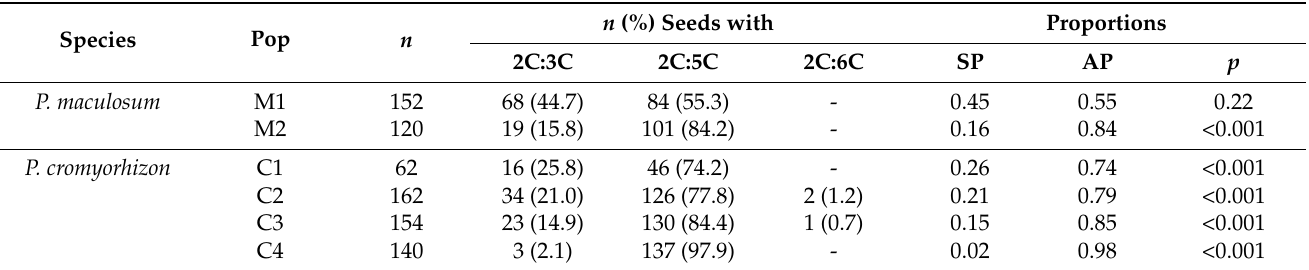
Table 2. Observed number and percentages (%) of seeds with different C-DNA ratios of embryo: endosperm in tetraploids of P. maculosum and P. cromyorhizon , and the observed proportions of the sexual (SP) and apomictic (AP) pathway at the seed